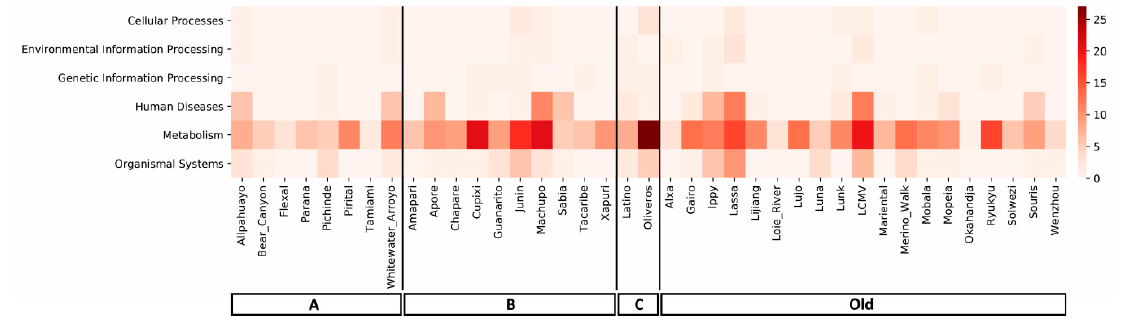
Figure 3. Heatmap of predicted miRNA–pathway group interactions for each mammarenavirus. Scale demonstrates how many times a pathway that belonged to a KEGG pathway group was targeted by a miRNA (if a miRNA targeted more than one pathway in the same group it was counted as many times).